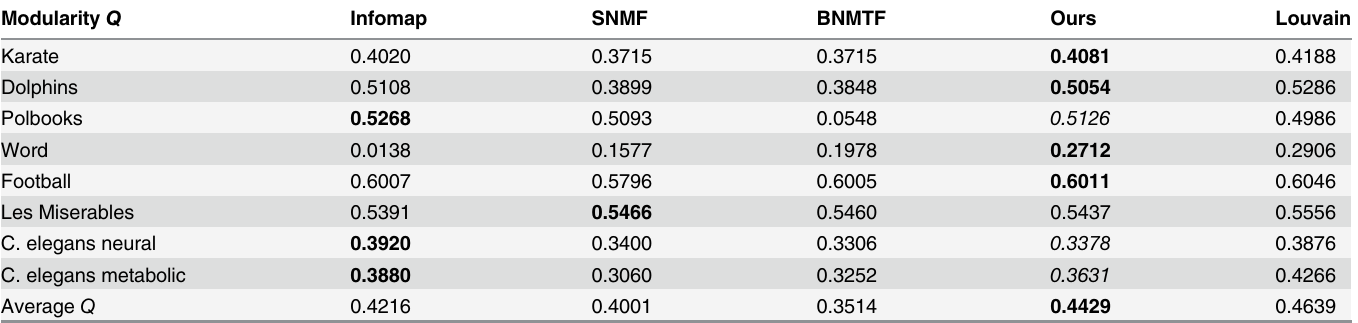
Table 3. Comparison with other methods in terms of modularity (Note that we mark the best results by boldface and our second best results by italic ). Modularity Q